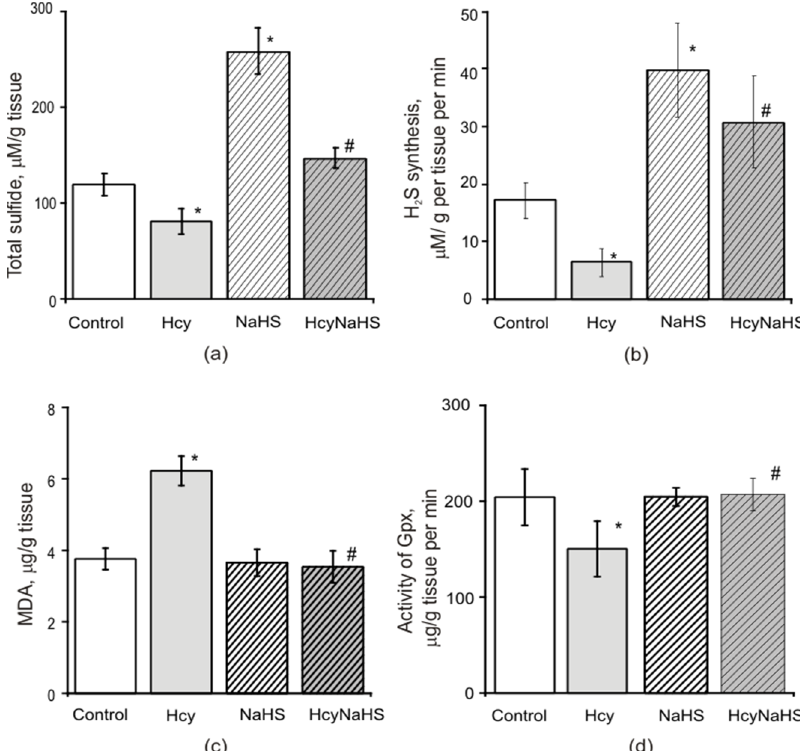
Figure 7. Effects of maternal hHcy and NaHS treatment on H 2 S concentration and the level of oxidative stress in rat brain tissues . H 2 S concentration ( a ) and activity of CBS ( b ) of rat brain tissues from control ( n = 21), Hcy ( n = 21), NaHS ( n = 21), and HcyNaHS ( n = 21) groups. The level of malondialdehyde (MDA) an end product of lipoperoxidation ( c ) and activity of the antioxidant enzyme—glutathione peroxidase (GPx) ( d ) in brain tissues of rats control ( n = 20, white columns); Hcy ( n = 20, grey columns), NaHS ( n = 19, dashed columns), HcyNaHS ( n = 20, grey dashed columns) groups. * p < 0.05 compared to the control group, # p < 0.05 compared to the Hcy group.